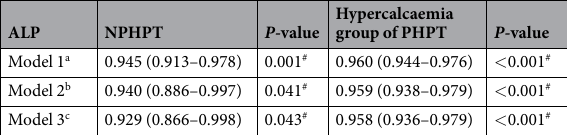
Table 5. Multivariate adjusted ORs (95% CI) of ALP between PHPT and normal control. a Model 1 was unadjusted. b Model 2 included age, sex and BMI for adjustment. c Model 3 included the covariate in model 2 plus Hb for adjustment. # p < 0.05.